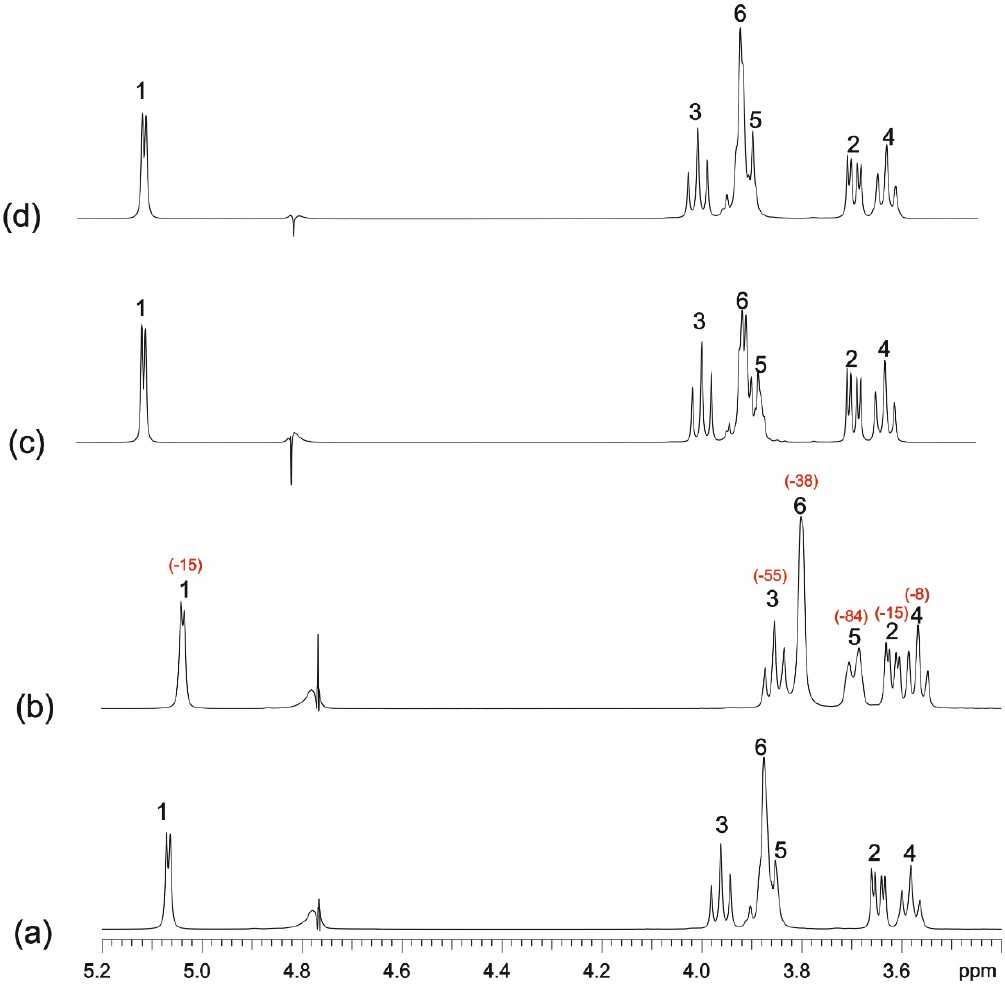
Figure 12. The fragments of the 1 H NMR spectra (3.4–5.2 ppm) of aqueous solutions of: β -CD, C β -CD = 0.50 m M (a), sample 3, C β -CD = C KP = 1.22 m M (b), sample 1 , C β -CD = 3.42 m M , C KP = 0.34 m M (c), sample 2 , C β -CD = 3.73 m M , C KP = 0.05 m M (d); in brackets, Δδ are given ( Δδ = δ obs – δ 0 is the chemical shift change of proton signals of β -CD, δ obs = the chemical shift of proton signals of β -CD at the presence of KP at given concentration, δ 0 = the chemical shift of proton signals of β -CD at 0.50 m M ; negative values indicate low-frequency shift, (Hz); temperature of 25 °C. Table 4. The experimental 1 H and 13 C NMR chemical shifts δ (ppm) for racemic KP in the presence of β -CD (equimolar solution, sample 3 ) in D 2 O, temperature of 25 °C.